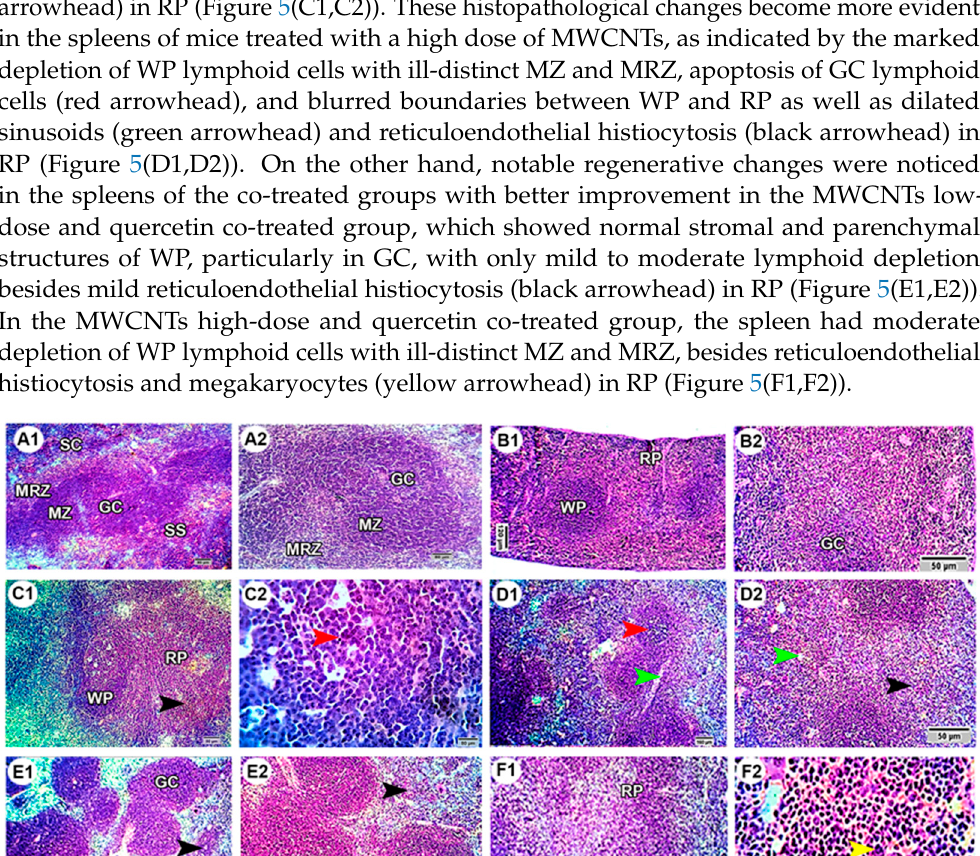
10 of 16 Figure 4. Effect of MWCNTs and/or quercetin on the relative expression of immunomodulatory genes (TGF β , COX2, IL10) as detected by qPCR. Data represent three independent experiments and were expressed as mean fold changes ± SEM (n = 5/group). Means within columns carrying different letters are significantly different at p ≤ 0.05. All groups were compared to each other. Cnt, control group; Que, quercetin-treated group; MWC-L, MWCNTs low dose-treated group; MWC-H, MWCNTs high dose-treated group; MWC-L+Que, MWCNTs low-dose and quercetin co-treated group; MWC-H+Que, MWCNTs high-dose and quercetin co-treated group.